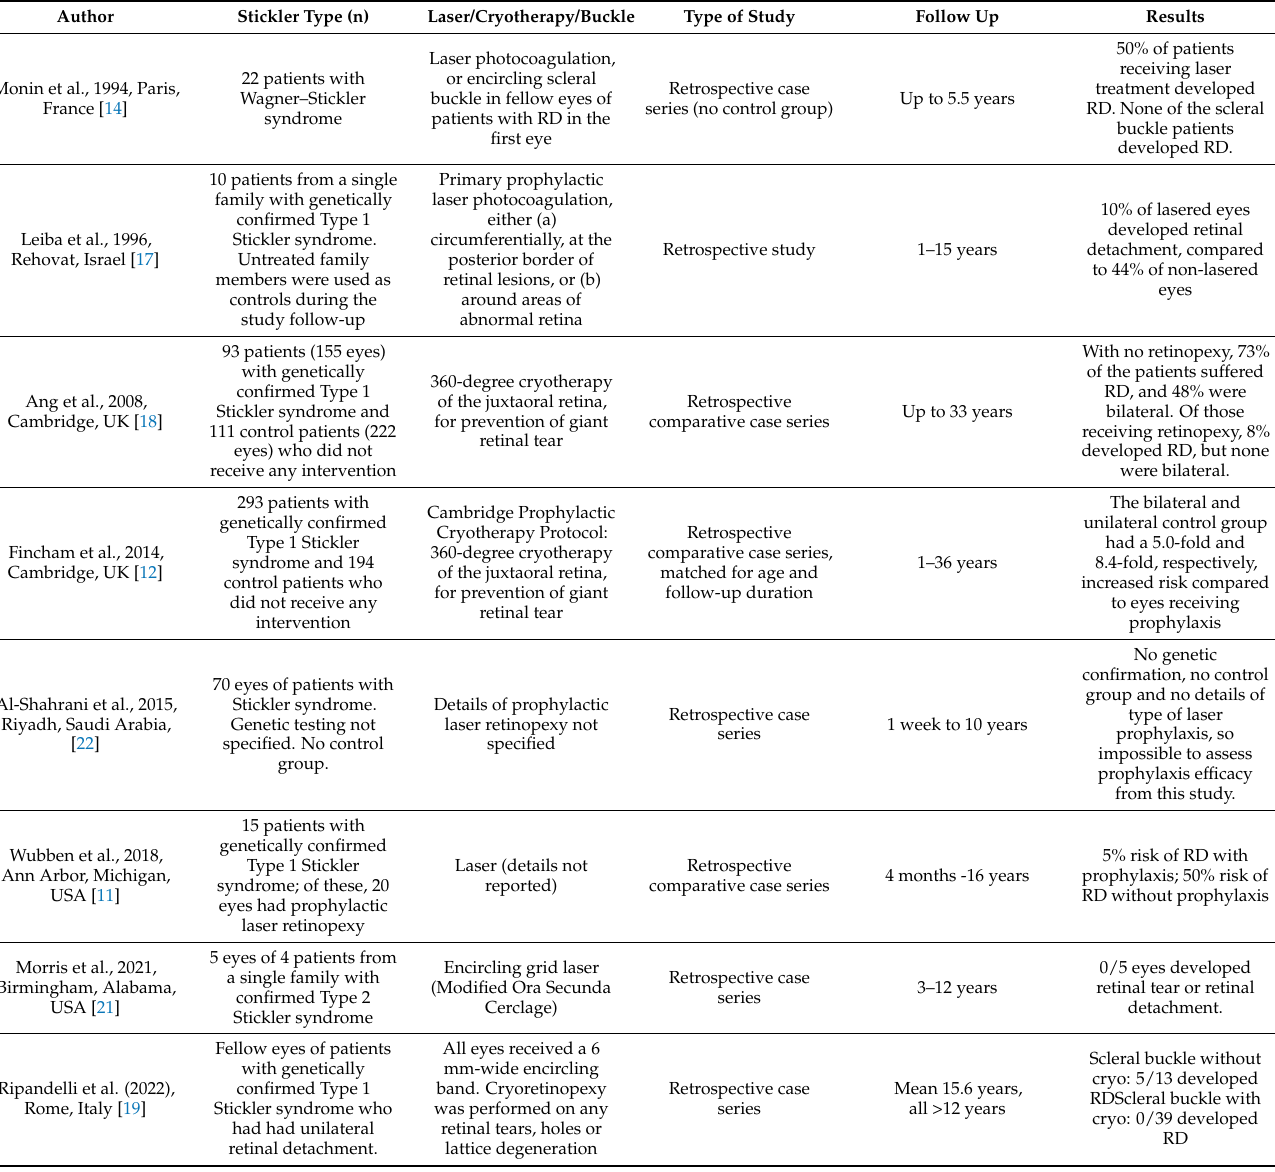
Table 1. Summary of studies evaluating strategies to prevent retinal detachment (RD) in patients with Stickler